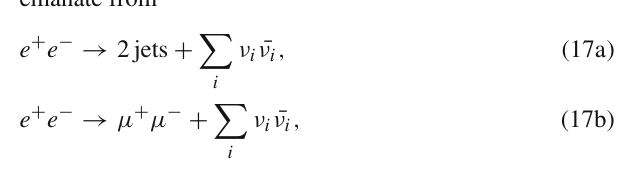
Fig. 5 Normalised 1-D differential distribution of the cross section w.r.t. kinematic observables P T j and Δφ jj for the background process ( shaded histograms ) and the Z → j j associated DM pair production at the three representative